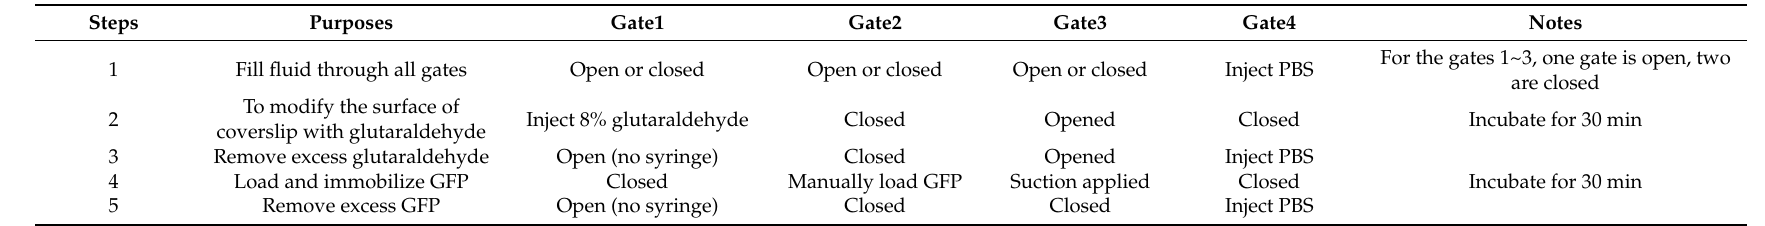
Table 1. Steps of on-chip immobilizing GFP protein on a